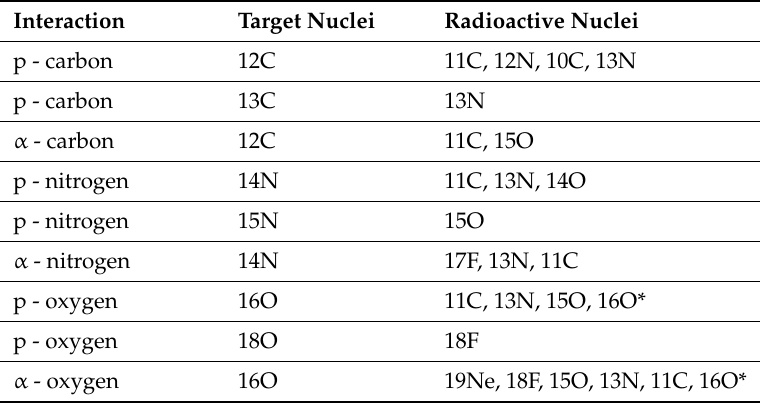
Table 1. Important interactions and the resulting radioactive